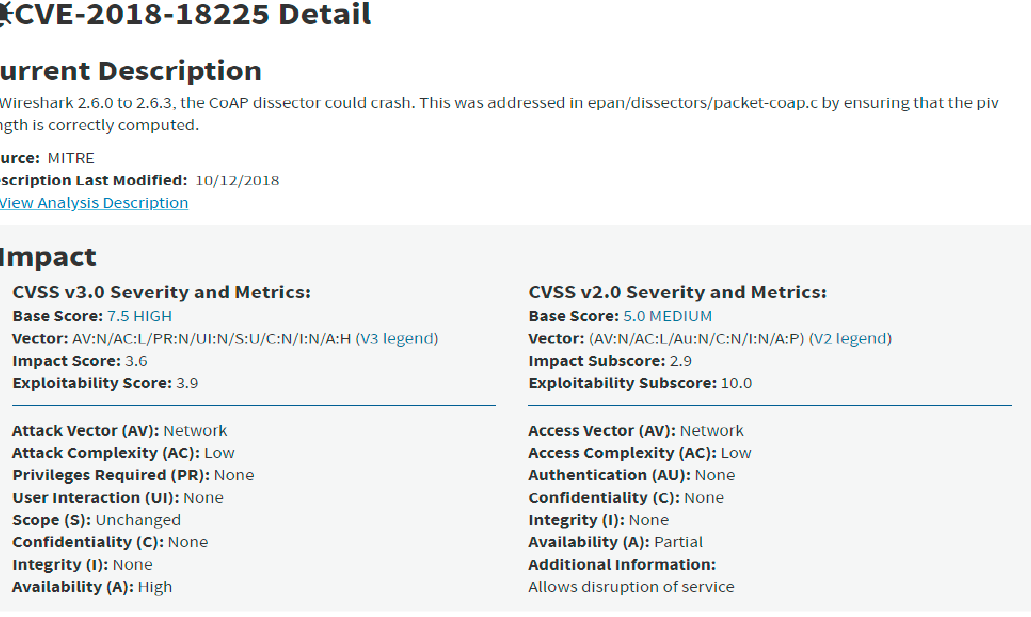
Figure 1. CVE-2018018225 details and common vulnerability scoring system (CVSS) scoring as displayed in Reference [6].